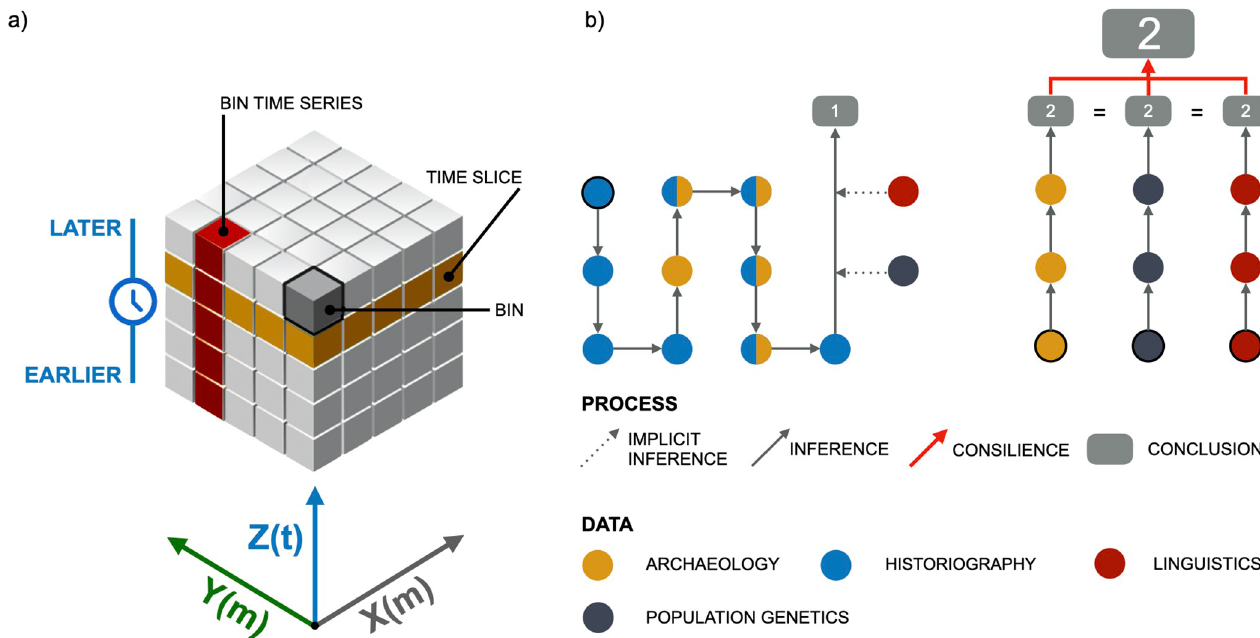
Fig 2. Graphical representations of selected methods: a) space-time cube model (after ESRI); b) comparison of two types of inference: On the left, data from different fields are compiled to draw a unified conclusion (analysis of Pohl’s [17] interpretation of our study region as an example), and on the right,